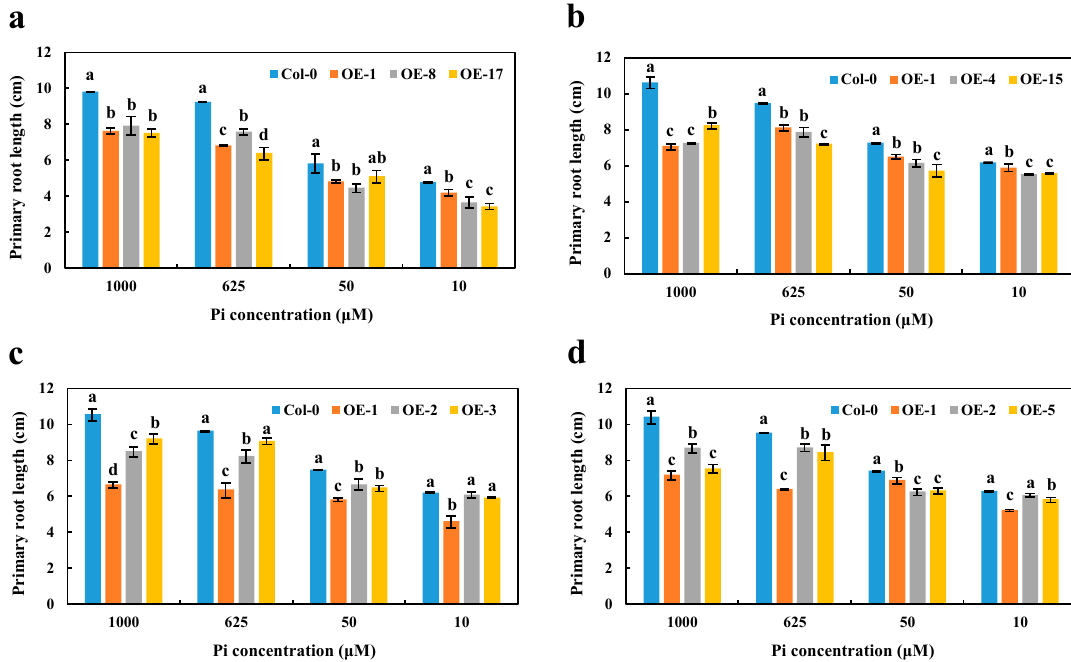
Figure 6. Primary root length comparison of the overexpression (OE) BnaCRF8 lines and the wild type (Col-0) at varied Pi conditions. Eleven-day-old plants grown on 10, 50, 625, and 1000 µ M Pi were imaged for primary root length measurement. ( a ) OE BnaA7.CRF8 lines; ( b ) OE BnaC2.CRF8 lines; ( c ) OE BnaA2.CRF8 lines; ( d ) OE BnaCn.CRF8 lines. Statistics were performed by Duncan’s test at the significance level of p < 0.05. Values represent mean ± SD, n = 4 replicates of 20 seedlings each. Small letters (a, b, c, and d) above the bars indicate mean with significant differences at p < 0.05 by Duncan’s test.